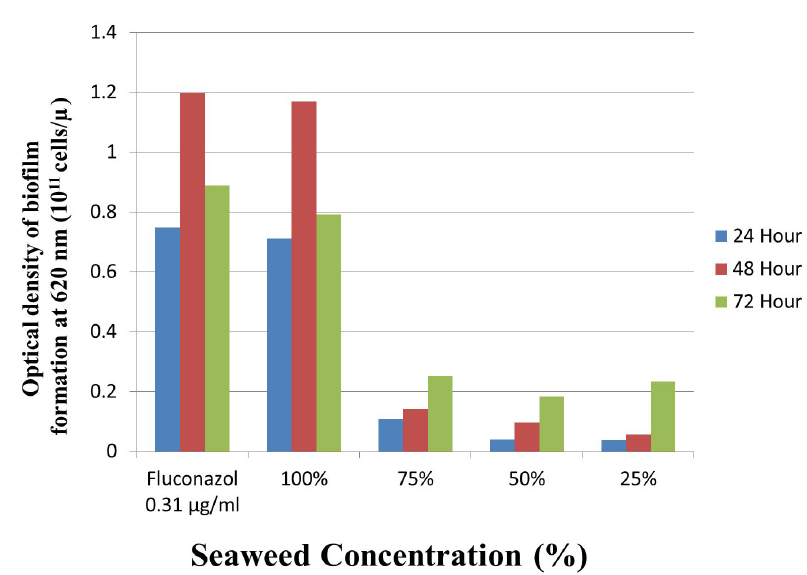
Figure 1. The formation of biofilm by Candida albicans exposed to seaweed Gracilaria verrucosa extract on different time exposures and